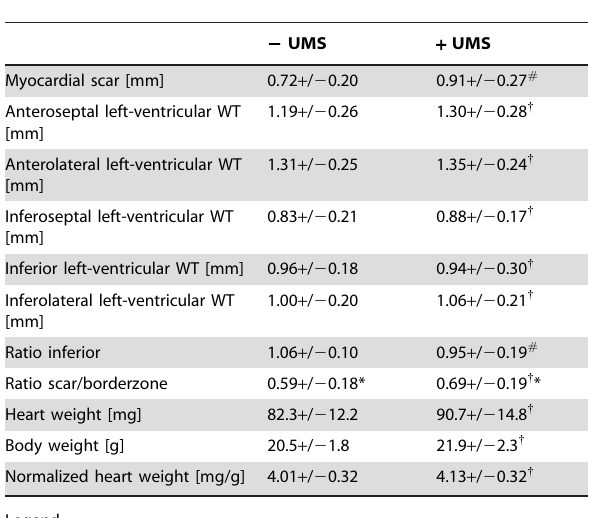
Table 2. Evaluation of hypertrophy derived from histomorphometric data.